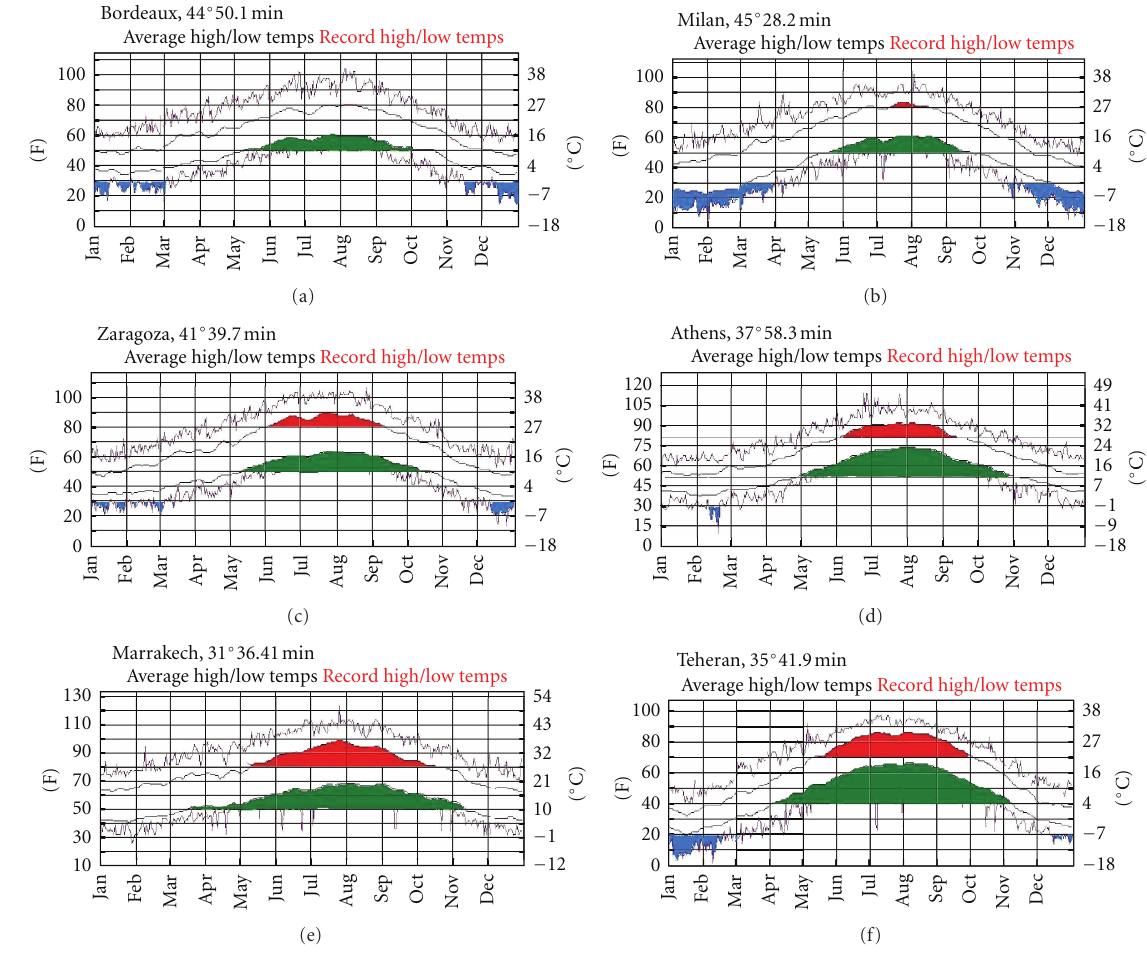
Figure 3: Maximum and minimum temperatures of six cities in the area of distribution of Sesamia nonagrioides . The curves, from bottom to top, show the record minimum temperatures, the mean minimum temperatures, the mean maximum temperatures, and the record maximum temperatures. Days with mean maximum temperatures higher than 27 ◦ C are colored in red, days with mean minimum temperatures higher than 10 ◦ C are colored in green, and days with temperatures below − 1 ◦ C are colored in